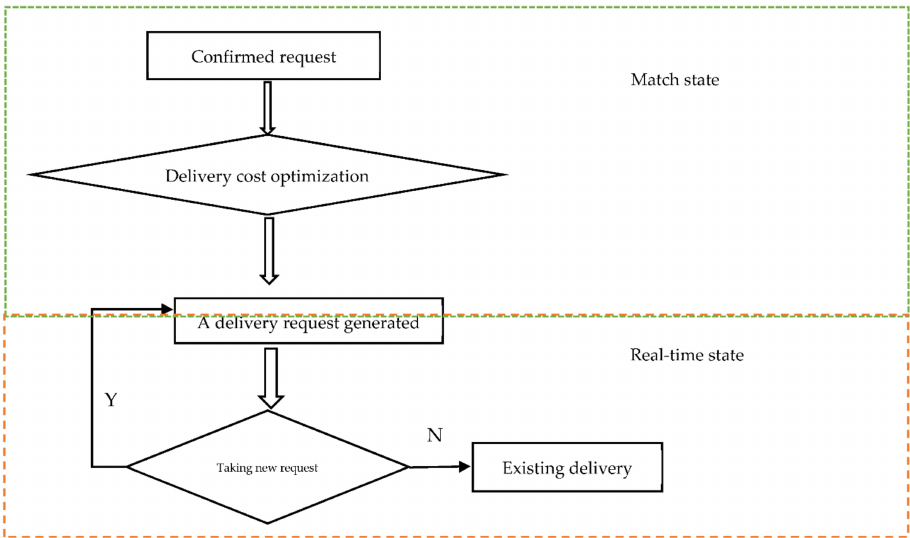
Figure 3. The analysis process of the decision-making